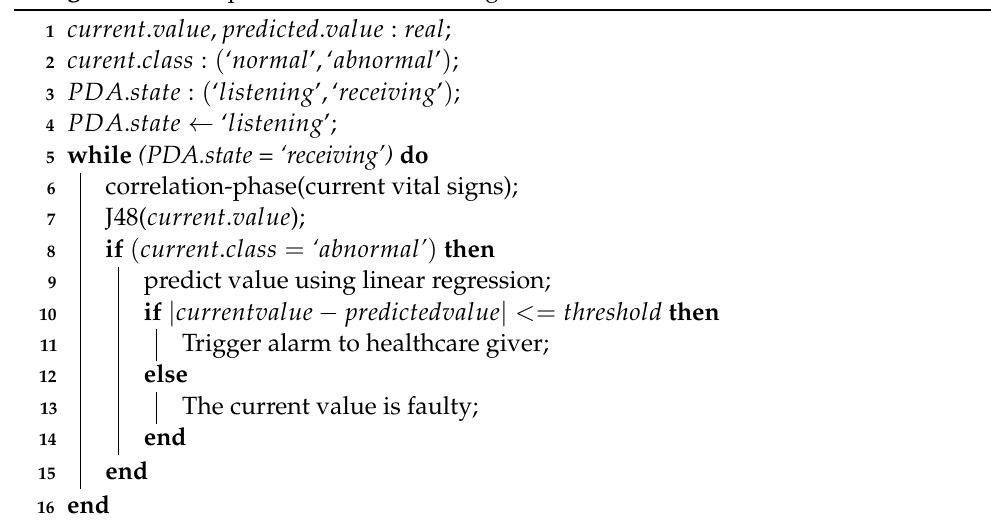
Algorithm 2: Proposed fault detection algorithm.